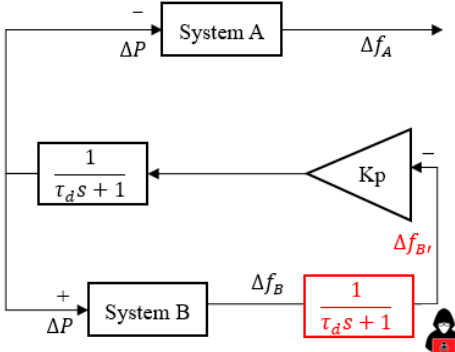
Figure 8. Denial of service attack in terms of E-FCR operation.